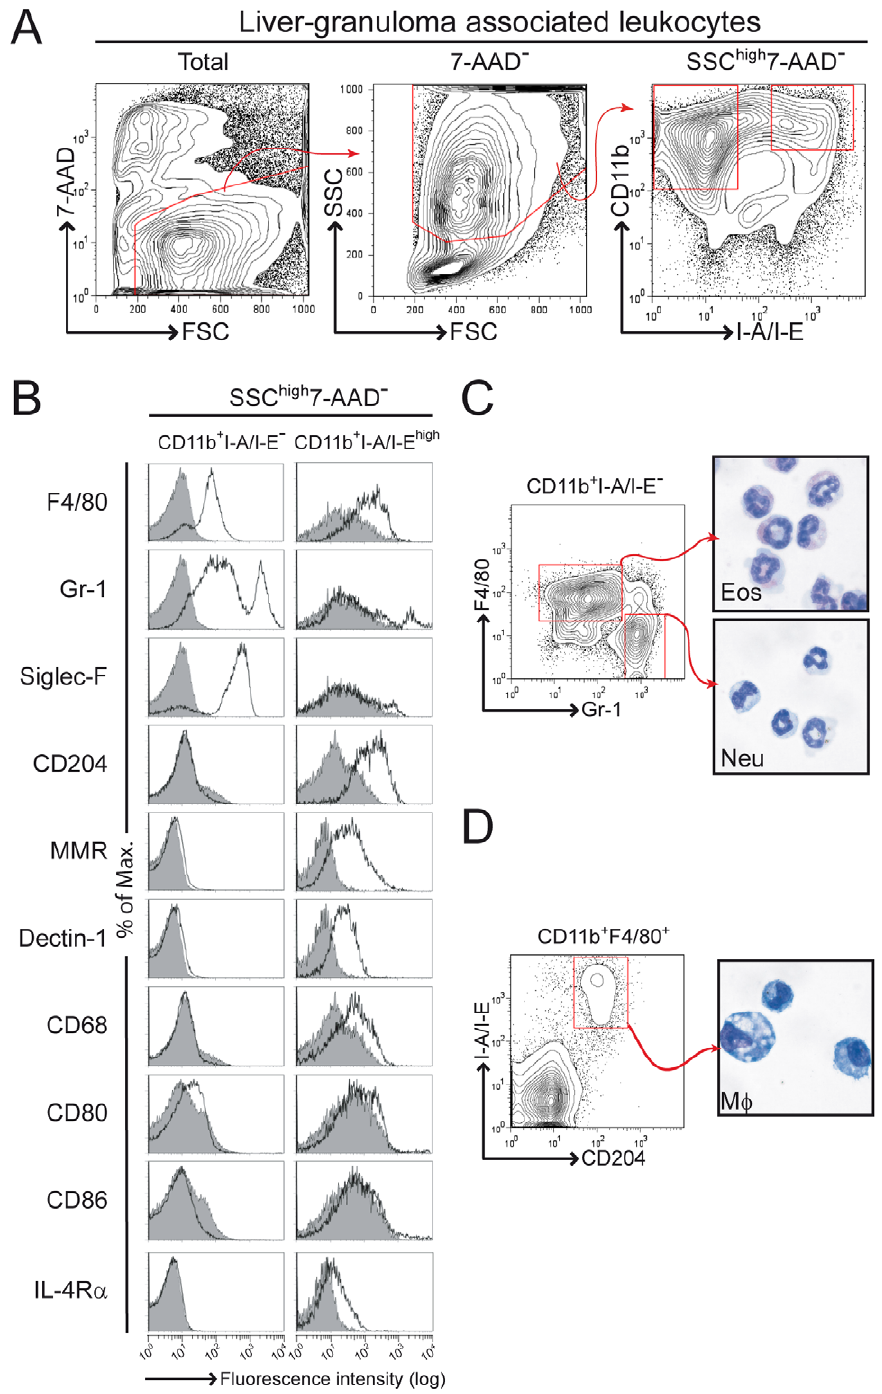
Figure 1. Flow cytometry analysis of liver granuloma during acute schistosomiasis. BALB/c mice were infected with 100 S. mansoni cercariae, killed 8 weeks later and liver granuloma-associated leukocytes isolated before 4-colour flow cytometry analysis. (A) Gating strategy for analysis of surface expression of CD11b and I-A/I-E on SSC high and live (7-AAD 2 ) liver granuloma-associated leukocytes. Outlined regions define CD11b + I-A/I-E 2 and CD11b + I-A/I-E high , respectively. (B) CD11b + I-A/I-E 2 , and CD11b + I-A/I-E high gated populations in A were analyzed for F4/80, Gr-1, Siglec-F, CD204, MMR, Dectin-1, CD68, CD80, CD86 and IL-4R a expression, respectively. Greyscale histograms show relevant isotype control. (C) 4- colour flow cytometry analysis of liver granuloma-associated leukocytes gated on CD11b + I-A/I-E 2 cells as described in A. F4/80 and Gr-1 double staining contour plot is shown. Outlined regions were sorted for cytospin and morphological analysis. (D) 4-colour flow cytometry analysis of liver granuloma-associated leukocytes gated on CD11b + F4/80 + cells as described in A. MHC-II (I-A/I-E) and scavenger receptor-A (CD204) double staining contour plot is shown. Outlined region was sorted for cytospin and morphological analysis. Data are representative of three independent experiments with similar results.